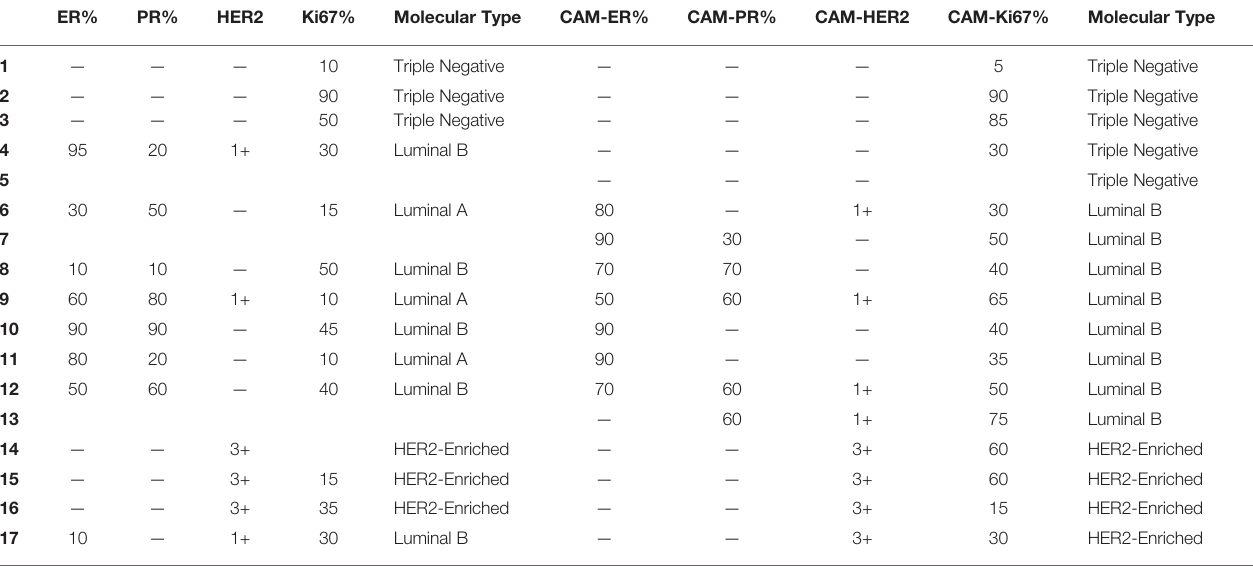
TABLE 2 | Molecular types of primary tumors and contralateral axillary lymph nodes.